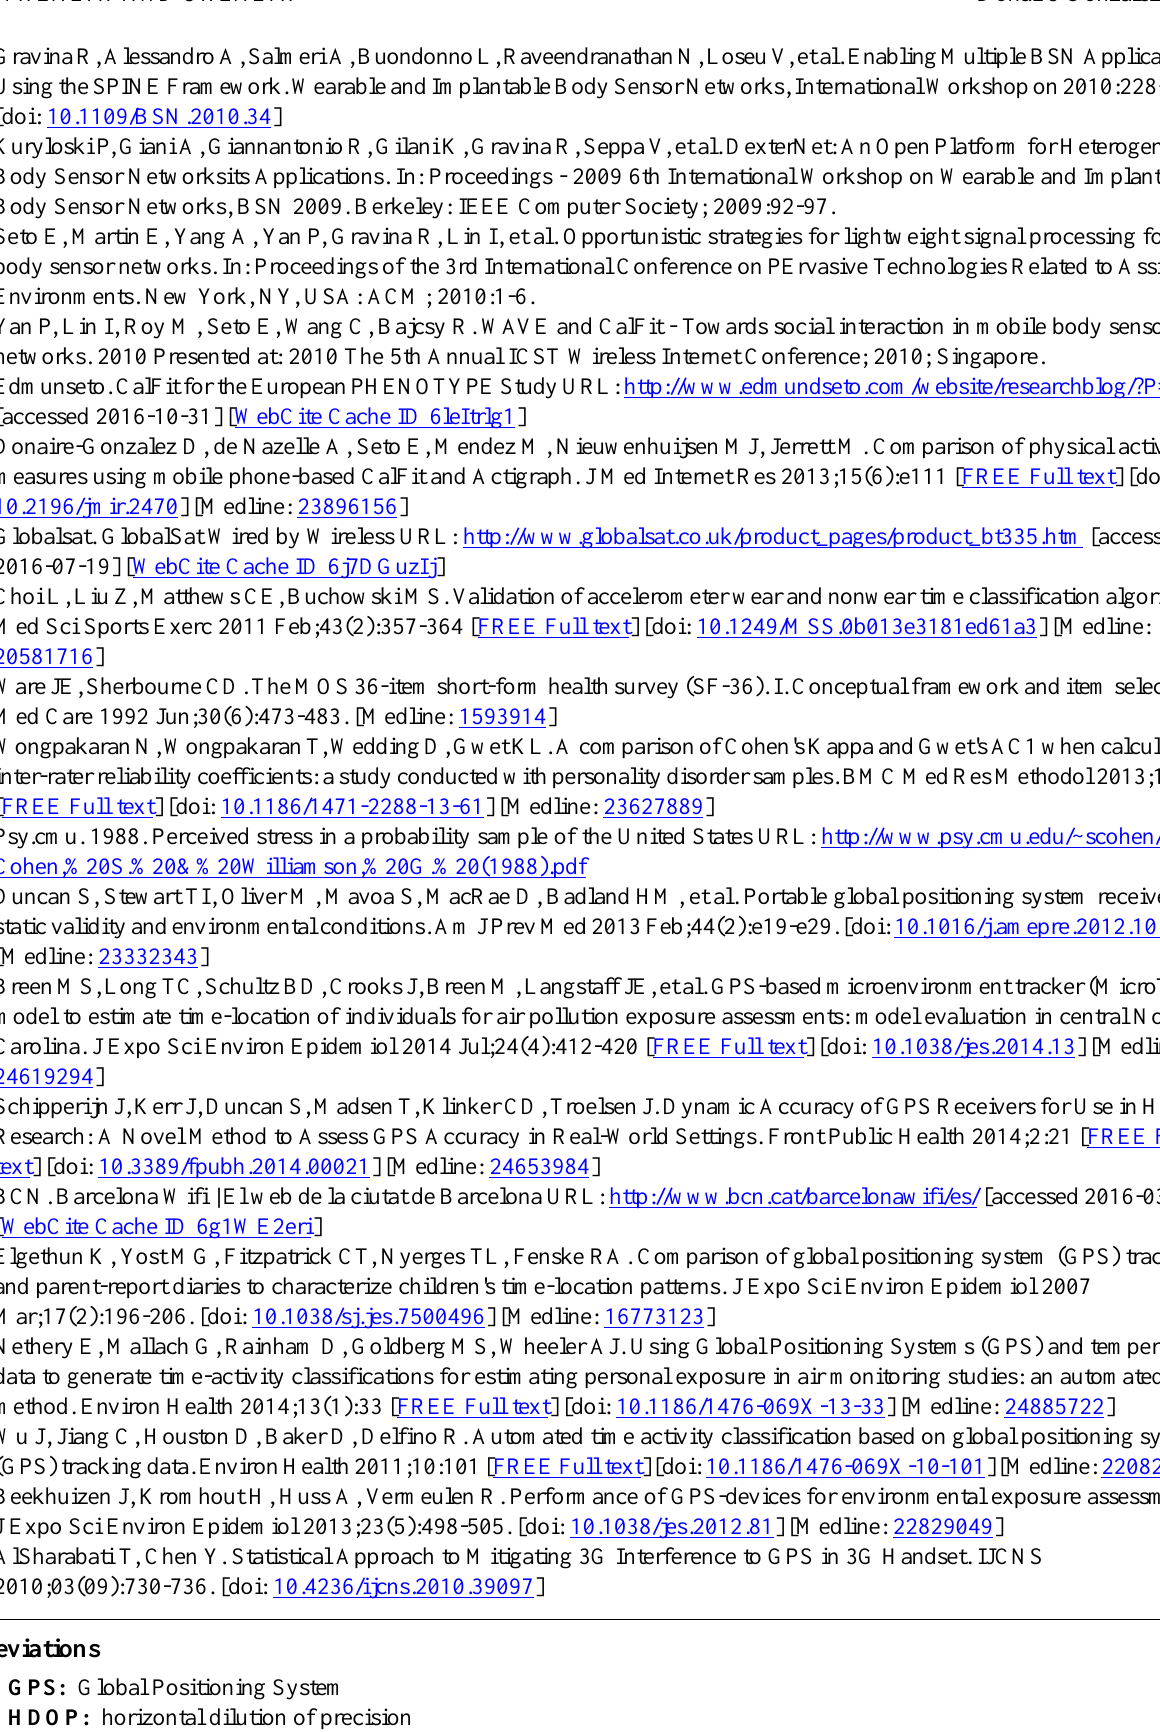
Abbreviations GPS: Global Positioning System HDOP: horizontal dilution of precision TAD: travel-activity